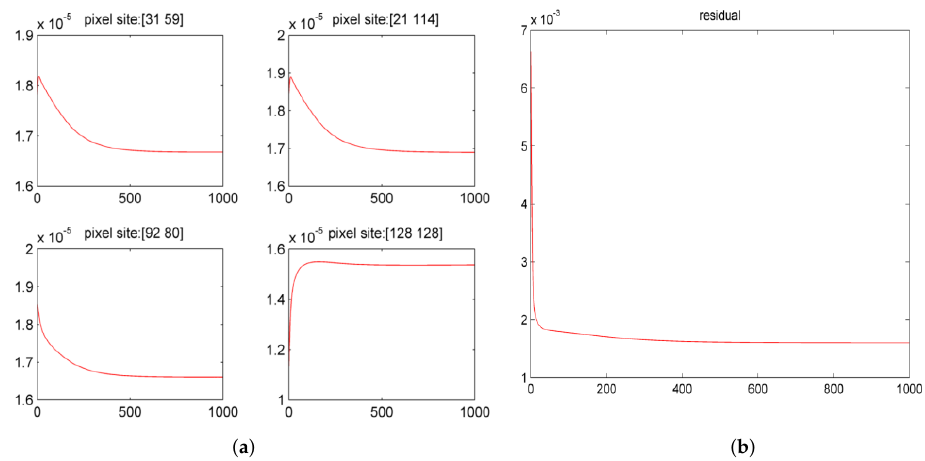
Figure 7. Pixel value curve and residual curve. The horizontal direction represents the number of iterations. The vertical direction represents the pixel